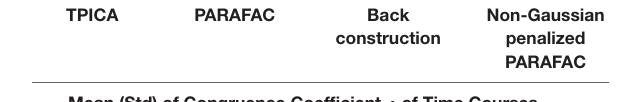
Non-Gaussian construction penalized